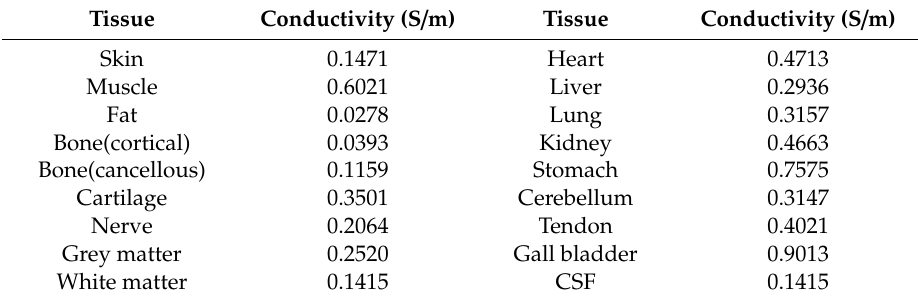
Figure 4. Simulation model of a shielded loop coil in the presence of a cylindrical model imitating a human body. ( a ) Simple cylindrical model and ( b ) realistic human body model. Table 1. Electrical Conductivities of selected tissues of TARO model at 6.78